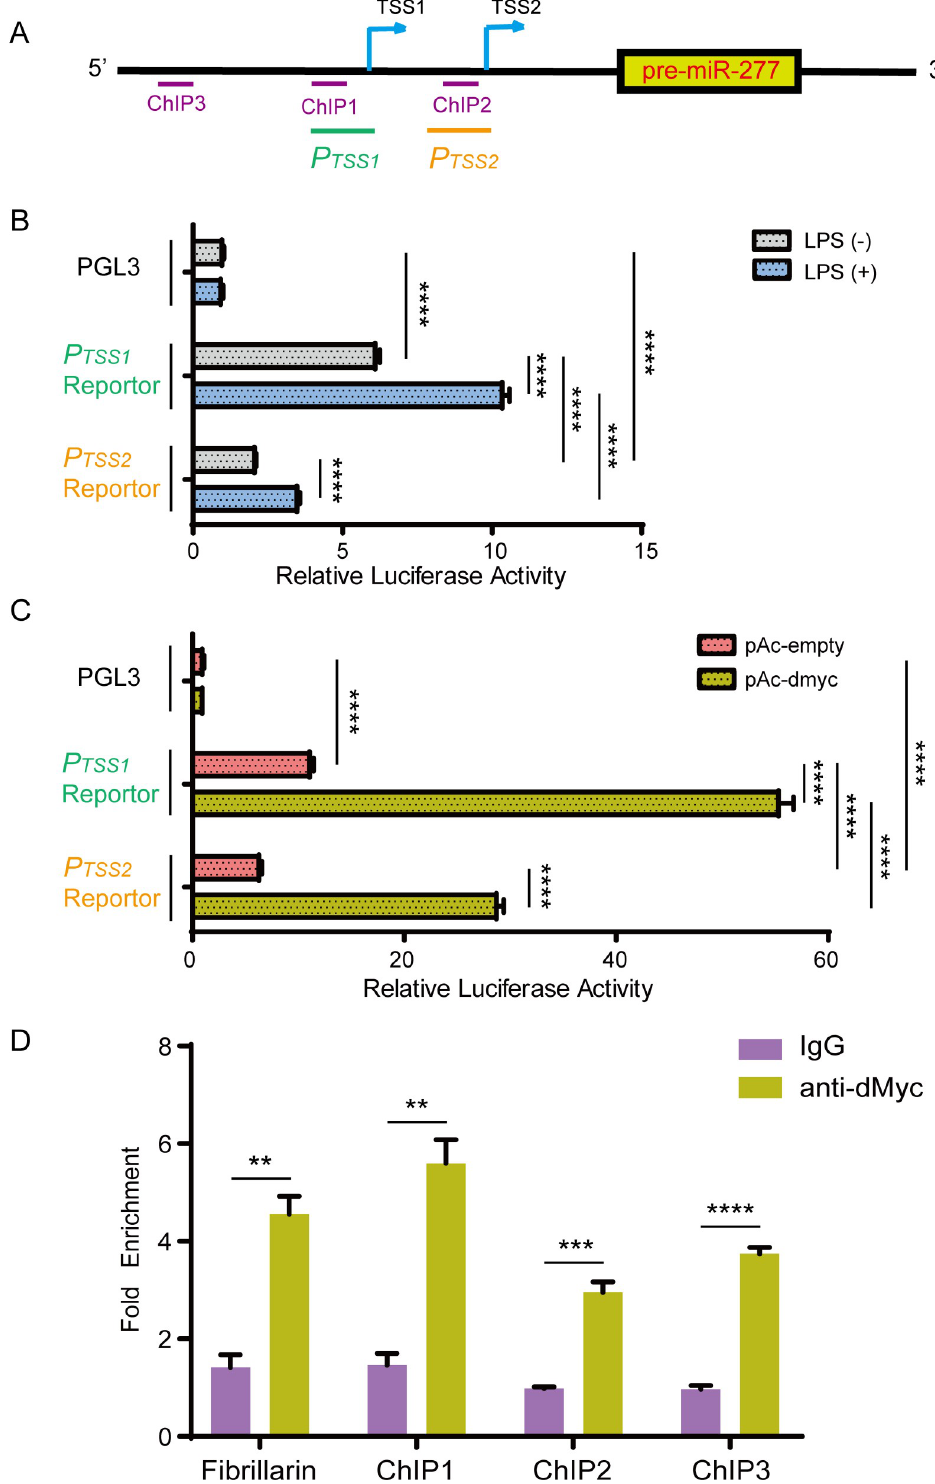
Fig 3. dMyc activates the transcription of miR-277 . (A) According to the two TSSs of the miR-277 promoter region, the P TSS1 (green line) and P TSS2 (orange line) region were selected to perform promoter activity analysis, while the ChIP1 , ChIP2 and ChIP3 sequences (purple line) were selected to design the primers for ChIP-qPCR